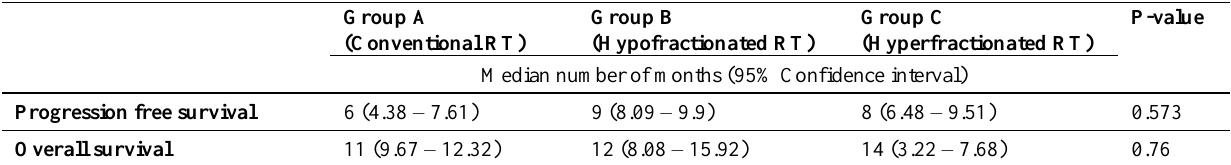
Table 2: Survival rates of the three fractionation schedules of radiotherapy